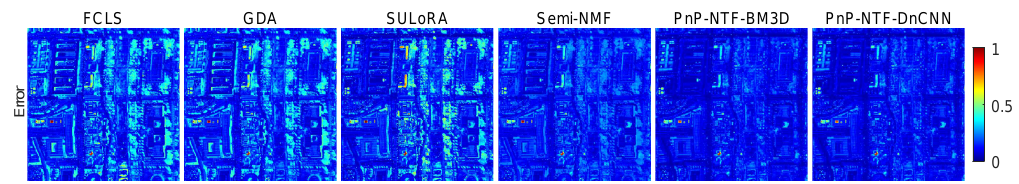
Figure 14. RE distribution maps comparison between the proposed algorithm and state-of-the-art algorithms on Washington DC Mall